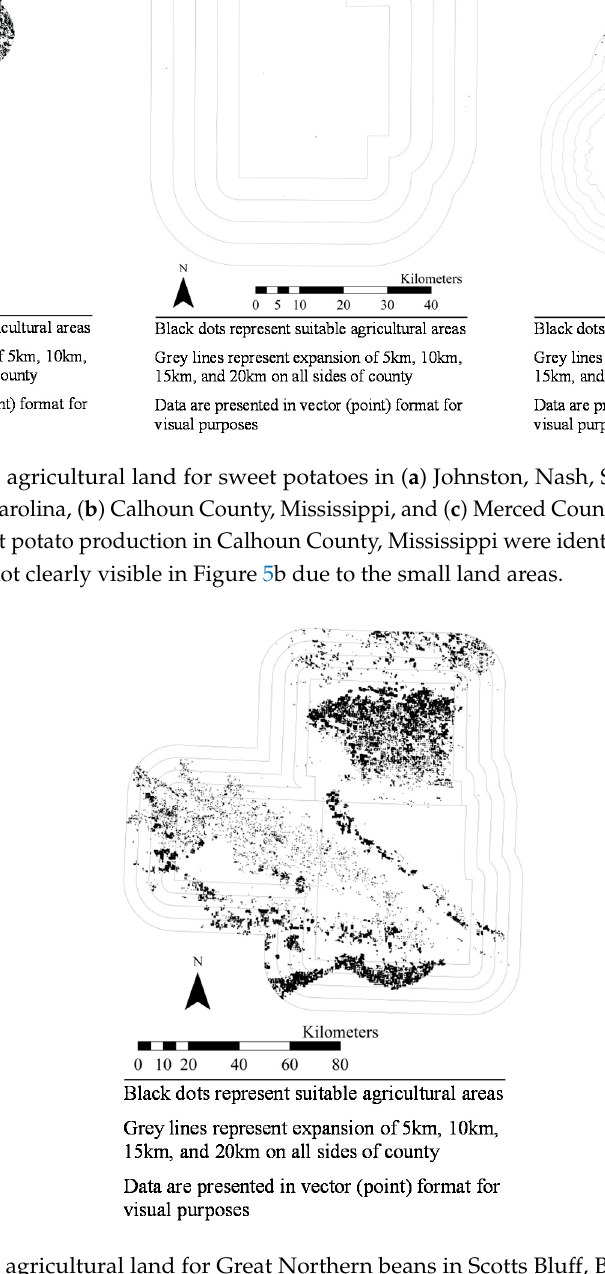
Figure 6. Suitable agricultural land for Great Northern beans in Scotts Bluff, Box Butte, and Morrill Counties, Nebraska.